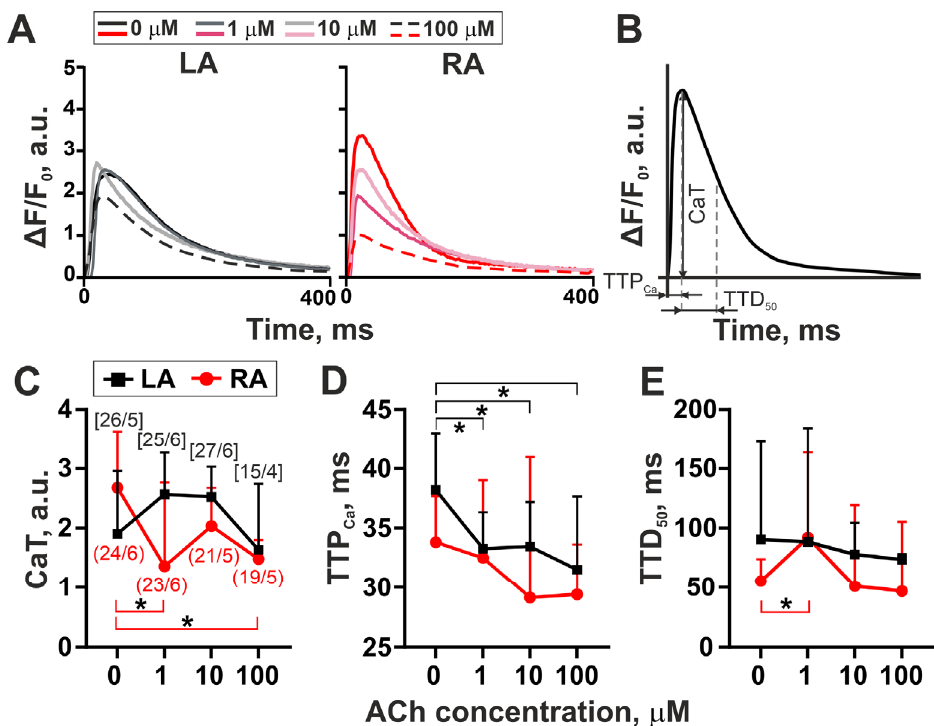
Figure 2. Dose–response curves of the amplitude and time course parameters of [Ca 2+ ] i transients in single mechanically non-loaded LA and RA cardiomyocytes to ACh (1–100 µ M). ( A ) Representative recordings of [Ca 2+ ] i transients in LA and RA cardiomyocytes from the control group (0 µ M) and after incubation with 1, 10, and 100 µ M ACh for 10–15 min. ( B ) Analyzed parameters derived from F/F 0 ([Ca 2+ ] i changes) signal. ( C ) Amplitude of [Ca 2+ ] i transient (CaT). ( D ) Time to peak [Ca 2+ ] i transient (TTP Ca ). ( E ) Time to 50% decay of [Ca 2+ ] i transients (TTD 50 ). The number of n cells from N hearts (n/N) is shown in square brackets [LA] or parentheses (RA) in the ( C ) panel. Values are plotted as medians with interquartile ranges. * p < 0.05: 1, 10, and 100 µ M ACh compared to the control group (0 µ M ACh); Kruskal–Wallis test for all